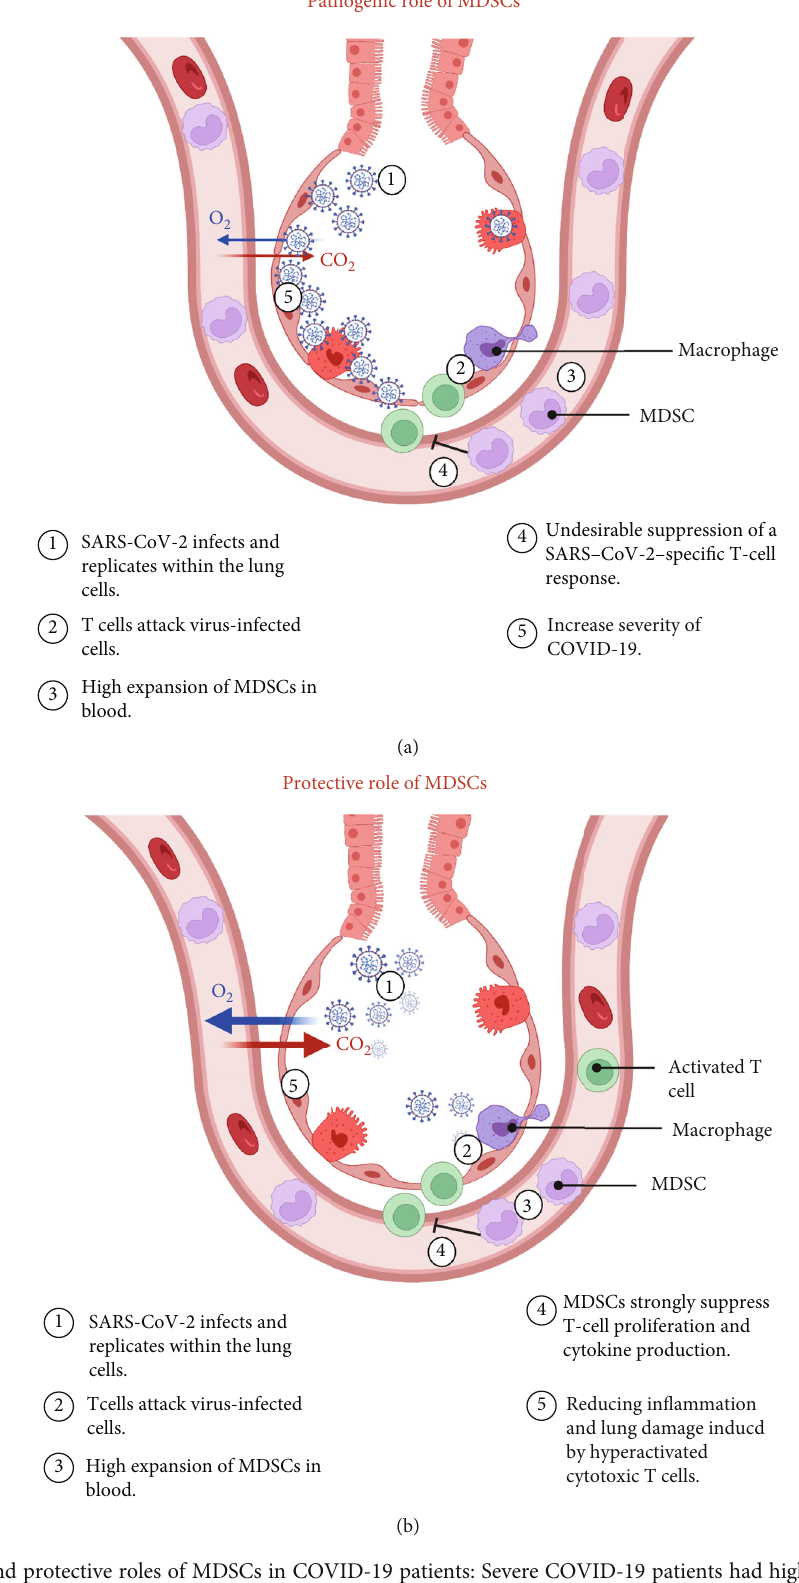
Figure 2: Pathogenic and protective roles of MDSCs in COVID-19 patients: Severe COVID-19 patients had higher levels of MDSCs. This might result in an undesirable suppression of SARS-CoV-2-speci fi c T cell responses, which can contribute to worse outcomes in these patients (a). MDSC expansion may help to limit an overly aggressive and possibly damaging immune responses by decreasing in fl ammation caused by hyperactivated T cells